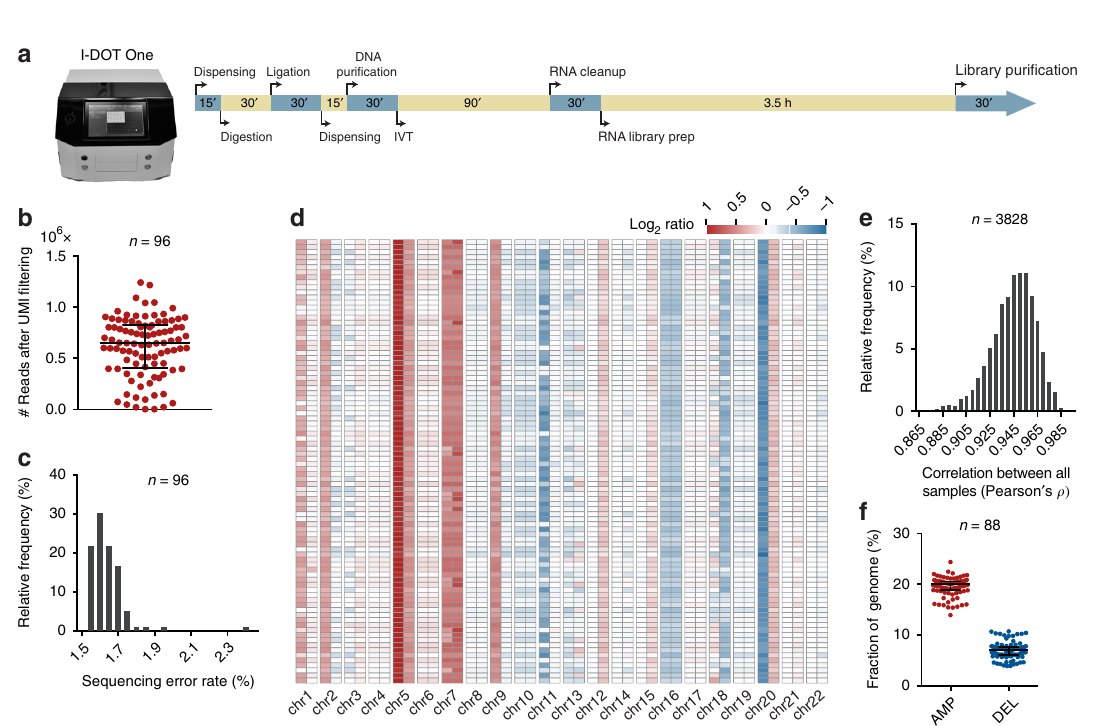
Fig. 4 High-throughput CUTseq. a Front picture of the I-DOT One MC, low-volume non-contact dispensing device (Dispendix) that was used in this study, and timeline for high-throughput CUTseq library preparation. IVT, in vitro transcription. The total work fl ow takes ~8 h for a single person to prepare 1 – 2 libraries, each containing up to 96 samples. The dispensing step can be done either manually or using a liquid handling device such as I-DOT One. b Number of usable reads (after alignment and PCR duplicates removal) per sample, in one multiplexed CUTseq library prepared from 96 replicate samples ( n ) of HeLa cells gDNA (5 ng), using I-DOT One. c Distribution of the sequencing error rates in the 96 replicates ( n ) shown in b . d Copy number pro fi les (1 Mb resolution, averaged at arm level for visualization) of 88 replicates shown in b that yielded at least 300 K usable reads. The remaining eight samples were not included, as the number of usable reads was insuf fi cient to perform reliable copy number calling. e Distribution of all possible ( n ) pairwise Pearson ’ s correlations between the copy number pro fi les shown in d . f Fractions of the genome either ampli fi ed (AMP) or deleted (AMP) in the 88 replicates ( n ) shown in d . Each dot represents one sample. Error bars indicate the median and interquartile range. All the source data for this fi gure